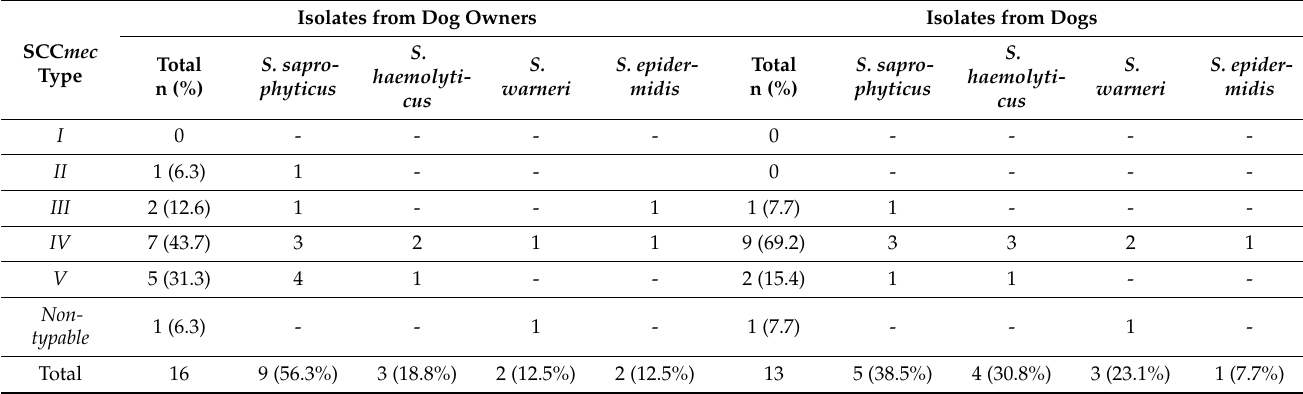
Table 6. Species and SCC mec types of MRCoNS from dog owners and